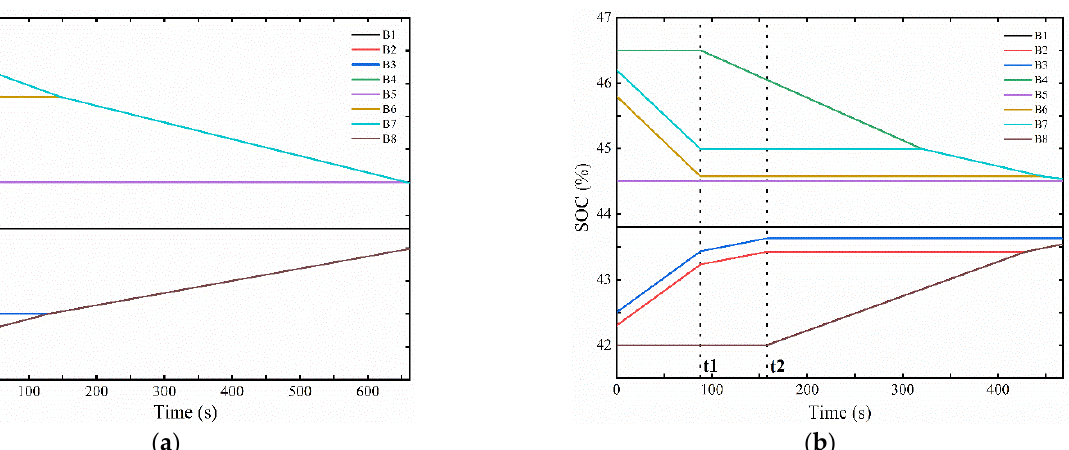
Figure 20. ( a ) AC2AC equalization simulation results ( b ) MC2MC equalization simulation results. Table 4. Equalization results for AC2AC and MC2MC control strategies.